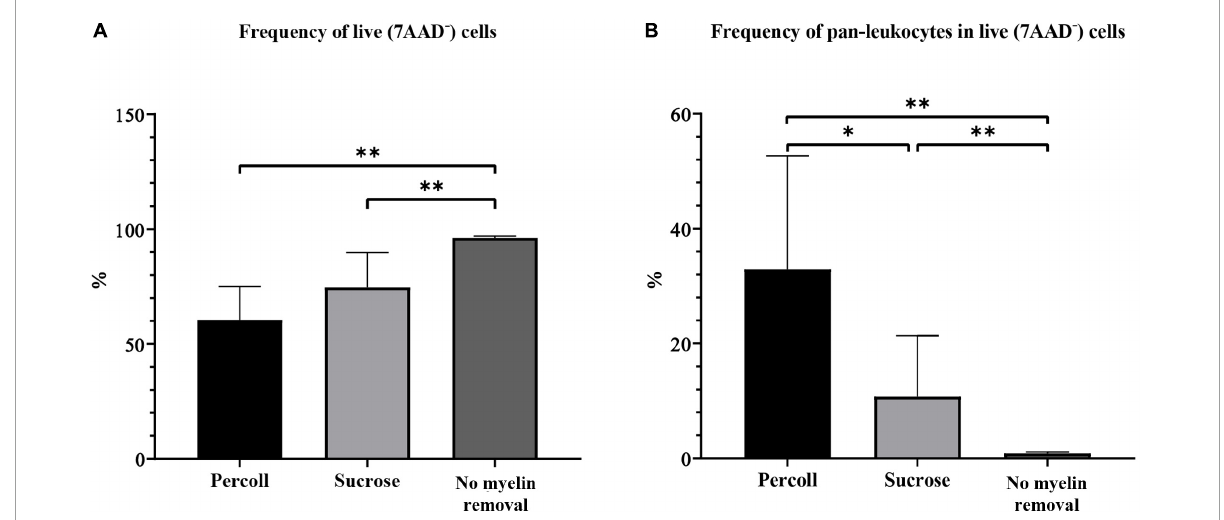
FIGURE5 The frequency of live cells (A) and pan-leukocytes (B) on flow cytometry obtained by different myelin removal methods. ∗ P < 0.05; ∗∗ P < 0.01. N (mice per group) =